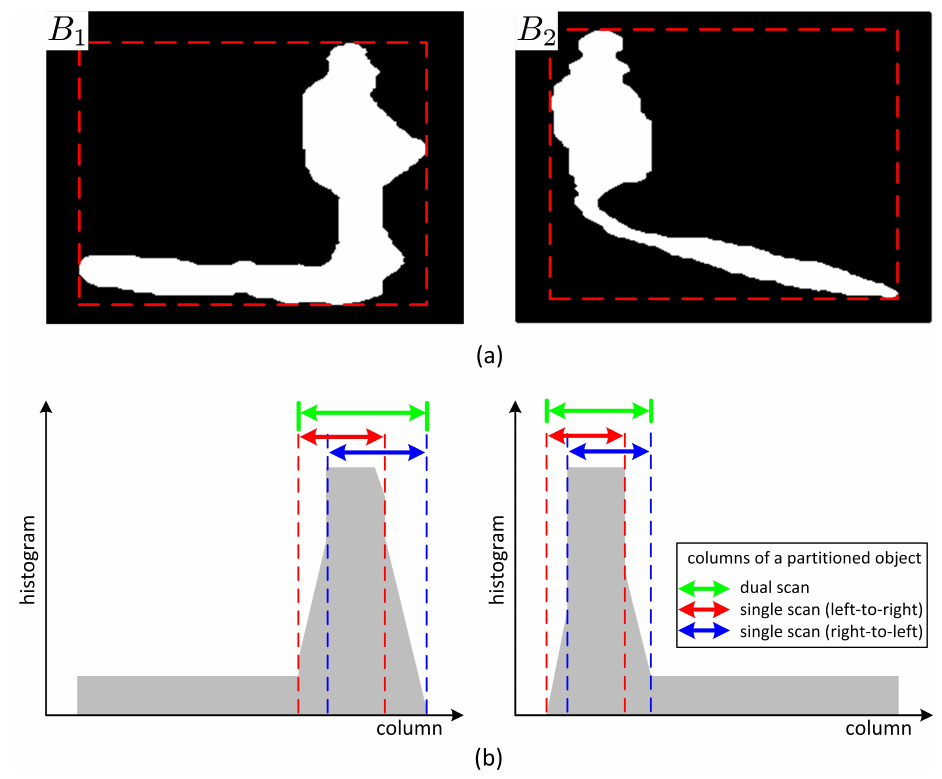
Figure 6. Partitioning of a foreground region by scanning the vertical histogram: ( a ) Foreground regions; ( b ) Foreground pixel histograms and the partitioned results for three scanning methods.